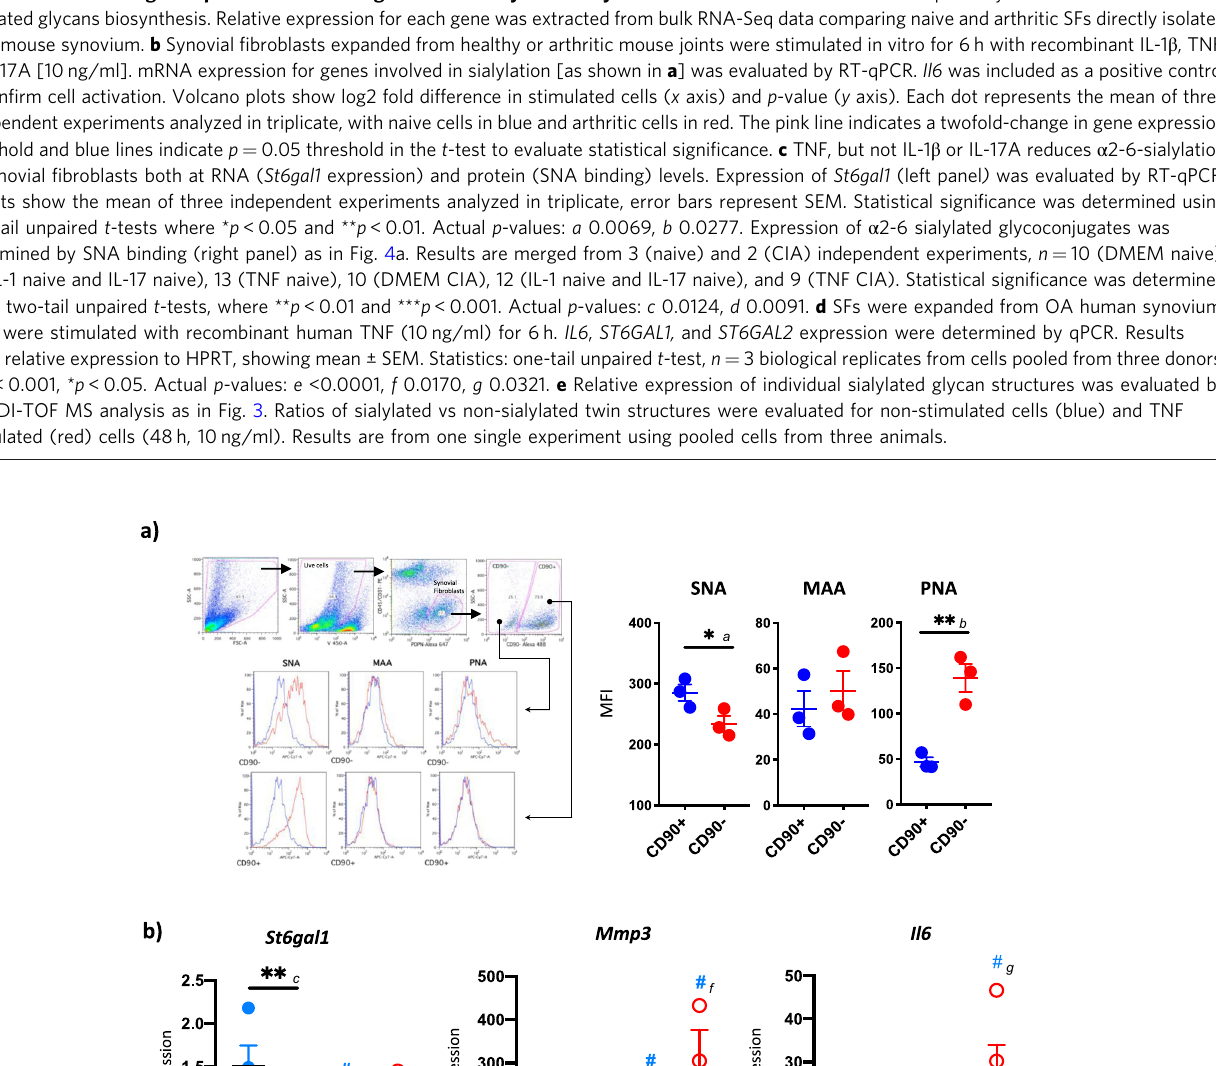
Fig. 6 Reduced α 2-6-sialylation is restricted to CD90 + synovial fi broblasts. a Synovial fi broblasts from healthy mice were isolated from mouse joints and identi fi ed by fl ow cytometry as in Fig. 1 (Zombie Violet − , CD45 − , CD31 − , Podoplanin + ), separated into CD90 + and CD90 − populations and stained with the biotinylated lectins SNA, MAAII, and PNA, and streptavidin-PE-Cy7. Graphs show the mean fl uorescence intensity for each lectin. Data are presented as mean ± SEM, dots represent cells from one individual mouse ( n = 3). One-tail unpaired t -test was used for statistics, ** p < 0.01, # p < 0.05. Actual p -values: a 0.0264, b 0.023. b Synovial fi broblasts from healthy and arthritic mice ( n = 4) were isolated from mouse joints as in a and RNA was puri fi ed using the RNeasy Mini Kit (Qiagen) according to manufacturer ’ s instructions. Expression of Il6, Mmp3, and St6gal1 mRNA was quanti fi ed by RT-qPCR. Data are presented as mean ± SEM. One-tail unpaired t -test was used for statistics, ** p < 0.01, # p < 0.05 compared to the same population in control healthy mice. Actual p -values: c 0.0118, d 0.0428, e 0.0103, f 0.0225, g fucosylated versus non-fucosylated or different mannose- biologic DMARDs) RA synovium, supporting our conclusion of containing glycans. This suggests that high sialic acid content is sialylation being an anti-in fl ammatory factor not only in the a distinctive feature of SF-glycome in RA patients in sustained mouse model but also in human RA. However, further studies are remission (Fig. 8a). In line with this, SNA binding revealed a necessary to determine the effect of SF sialylation in human RA. higher expression of α 2-6 sialic acid in the synovium of RA Given the disease heterogeneity, different disease stages and patients in remission after c-DMARDs + TNF-inhibitor treat- patient groups must be considered to extract clinically relevant ment (Fig. 8b) compared with OA and naive (not exposed to conclusions.